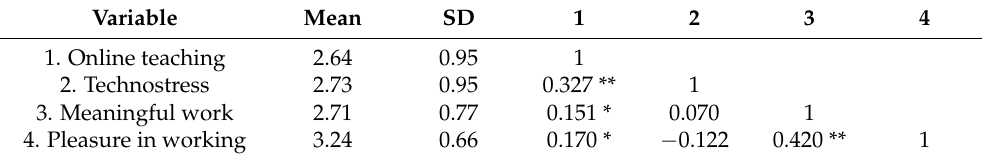
Table 1. Means, standard deviations, and correlations among study variables (N = 219). Variable